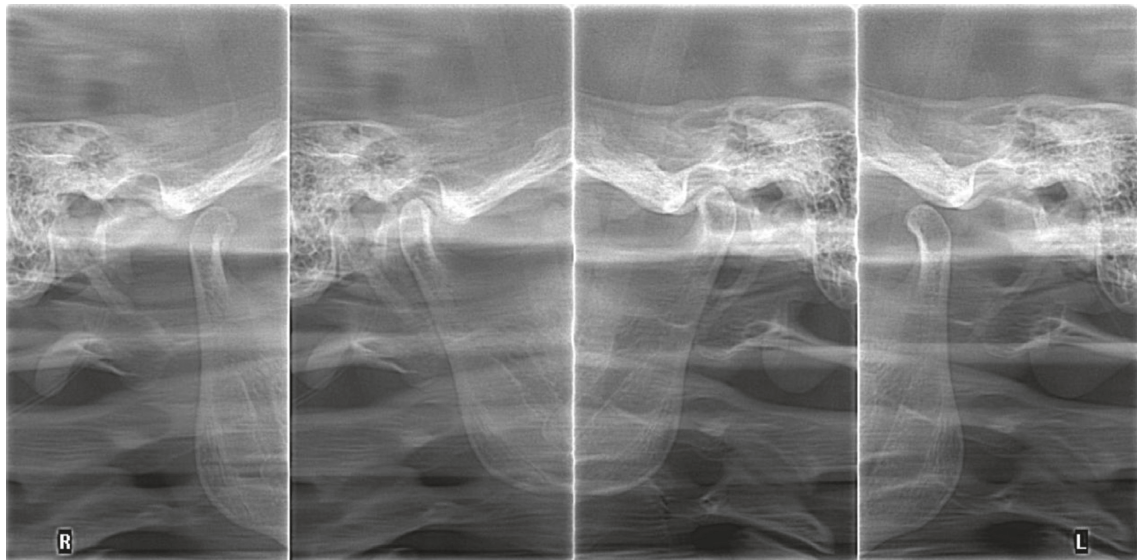
Figure 19: The radiographs of the TMJ with nonconcentric condylar position: an excessive left-sided occlusal vertical dimension (inferior condylar position in occlusion—internal scan, left